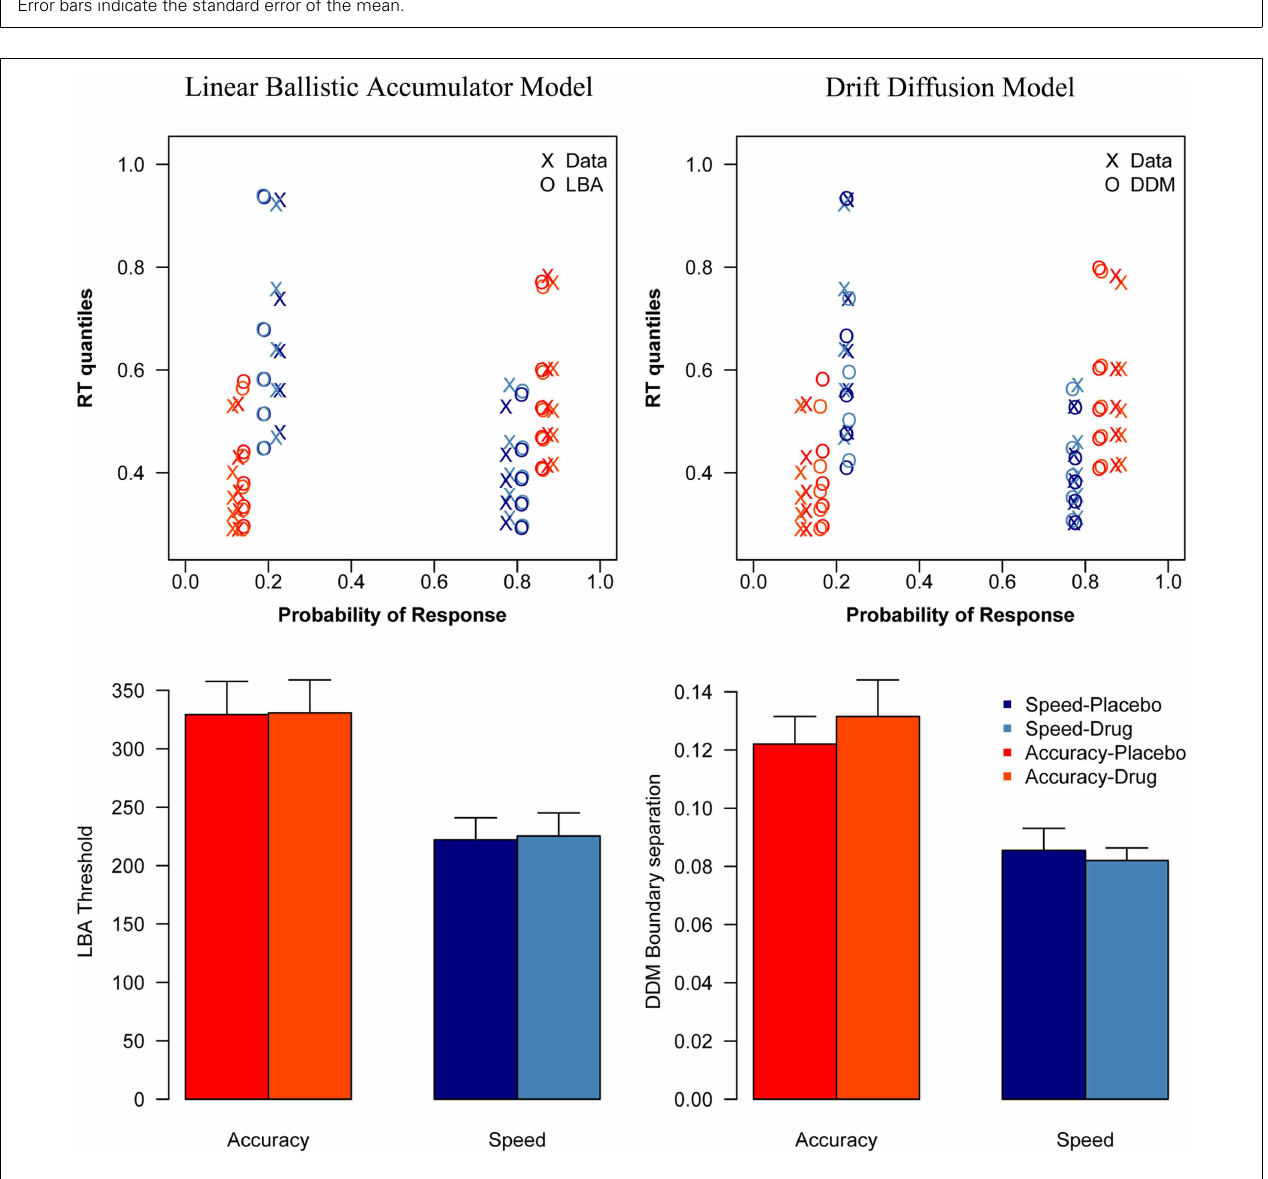
(right). As the reaction time distributions in the top figure are plotted by their probabilities, the error distributions are shown on the left side of each plot, while the correct distributions are shown on the right